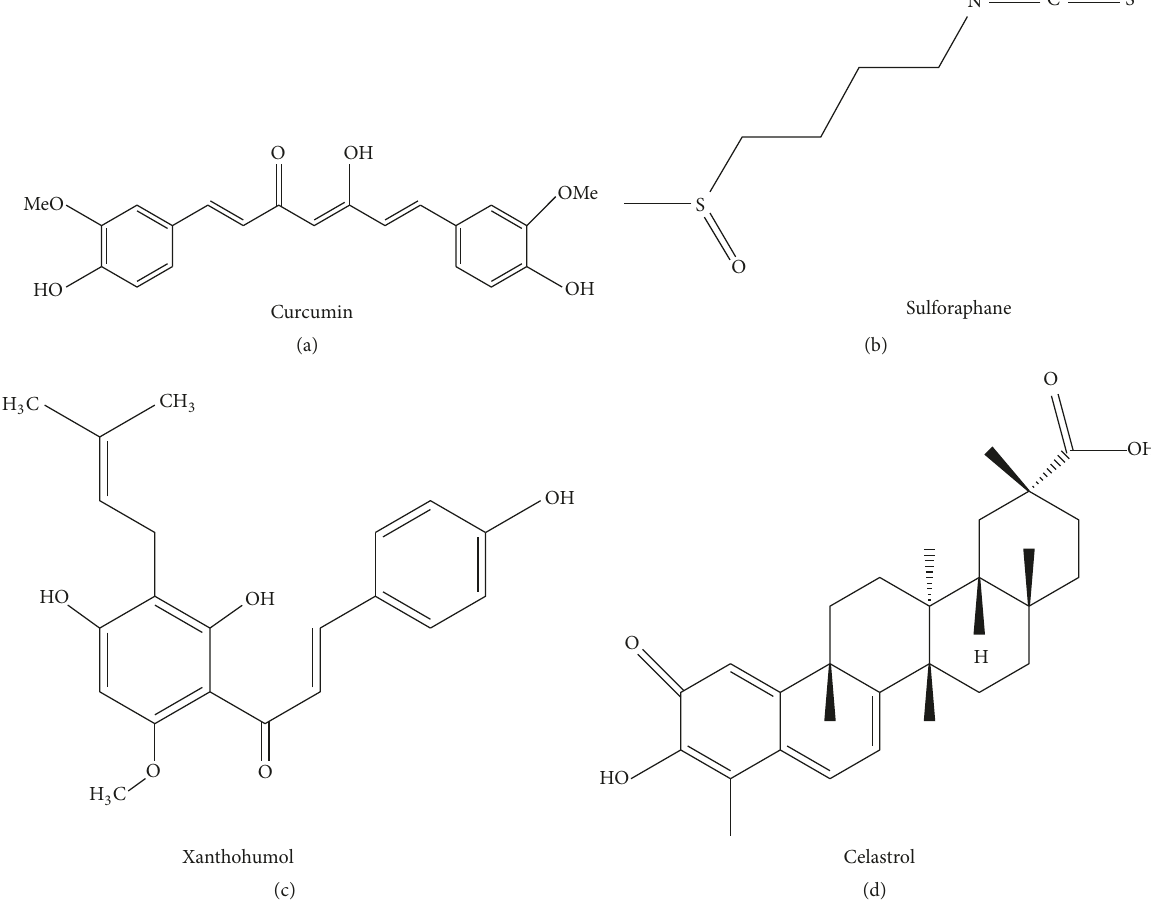
Figure 5: Structure of curcumin (a) and sulforaphane (b), xanthohumol (c), and celastrol (d). Sources: curcumin structure: [24], under